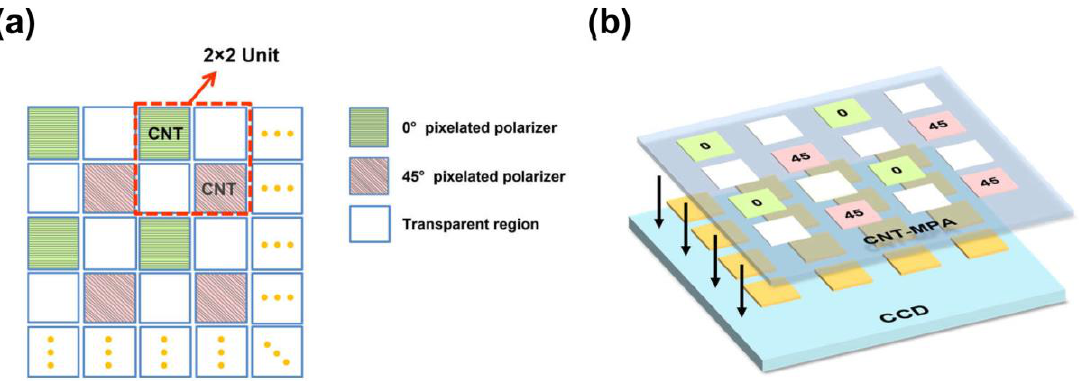
Figure 1. ( a ) The schematic diagram of MPA, a 2 × 2 unit containing a 0° pixelated polarizer, a 45° pixelated polarizer, and two transparent regions. ( b ) Schematic diagram of the integration of the MPA and the image sensor.